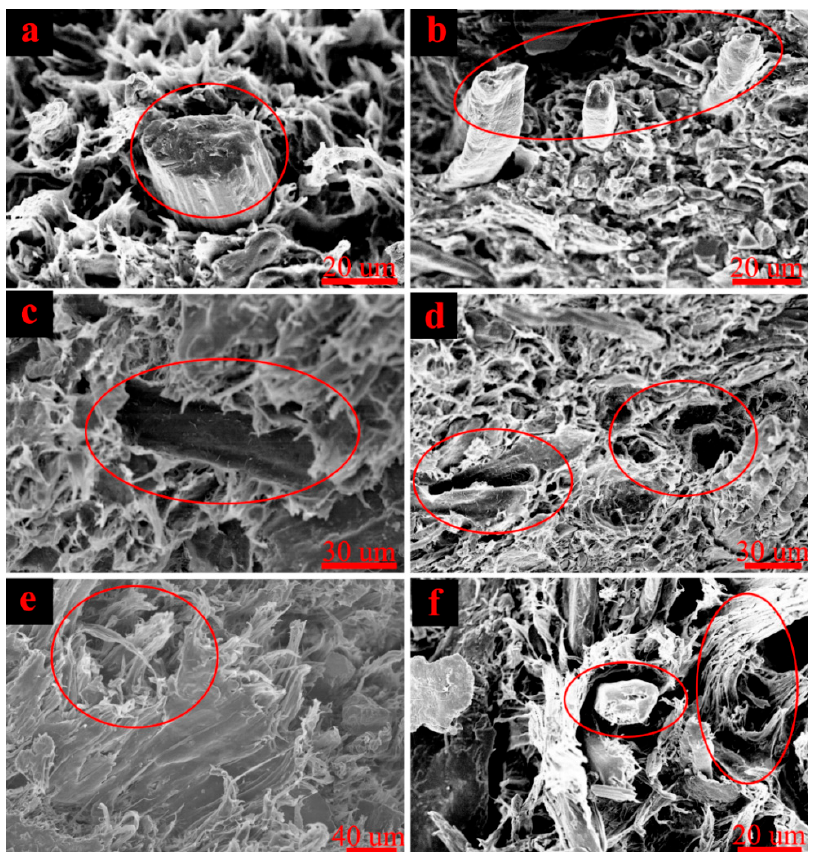
Figure 3. Scanning electron microscope (SEM (analysis of damage and fracture mode and characteristics (( a , b )—Fiber breakage; ( c , d )—Fiber pull-out (interface friction); ( e )—Matrix cracking; ( f )—Fiber-matrix debonding (interface delamination) and matrix deformation).